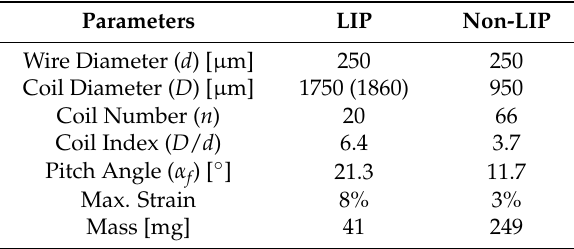
Table 3. Design parameters of two SMA coil spring actuators for comparison of LIP and non-LIP (0.5 N load, 40 mm